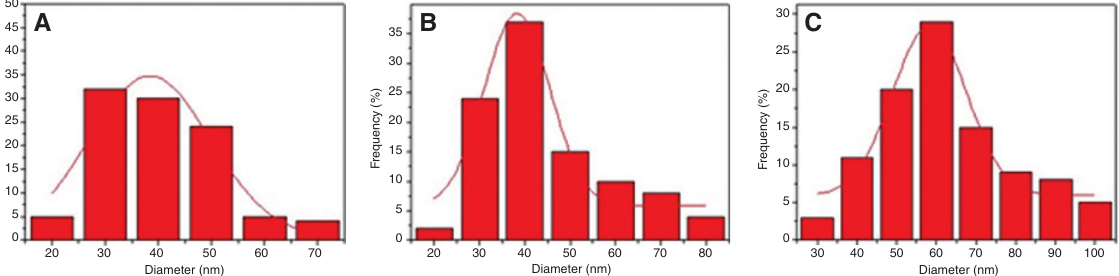
Figure 7: Particle size distribution of Zn 2 + doped MgO nanoparticles that calcinated at: (A) 600 ° C, (B) 700 ° C, and (C) 800 ° C.